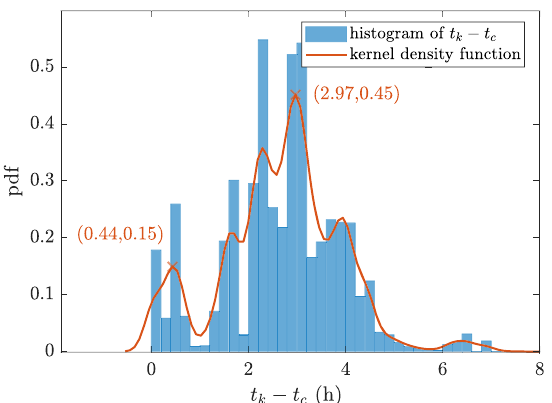
Fig. 8 The probability distribution function (pdf) of Exceptional Strides in relation to medication intake time (blue) with the fi tted Gaussian mixture model (red). Two peaks can be distinguished from the kernel smoothening function at 0.44 and 2.97